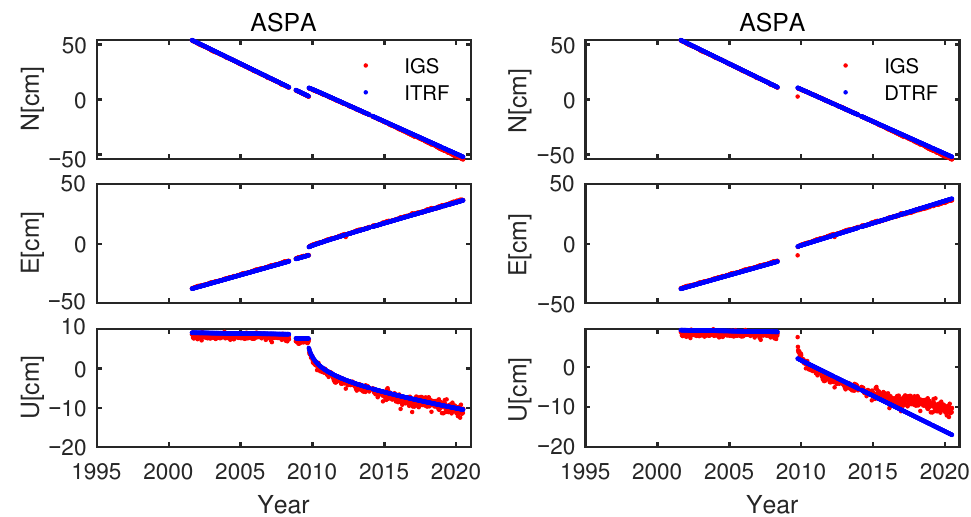
Figure 6. The station position time series of ASPA: left for ITRF2014, right for DTRF2014, and the IGS time series for both left and right as a comparison. The average values of IGS solutions are taken from individual components.